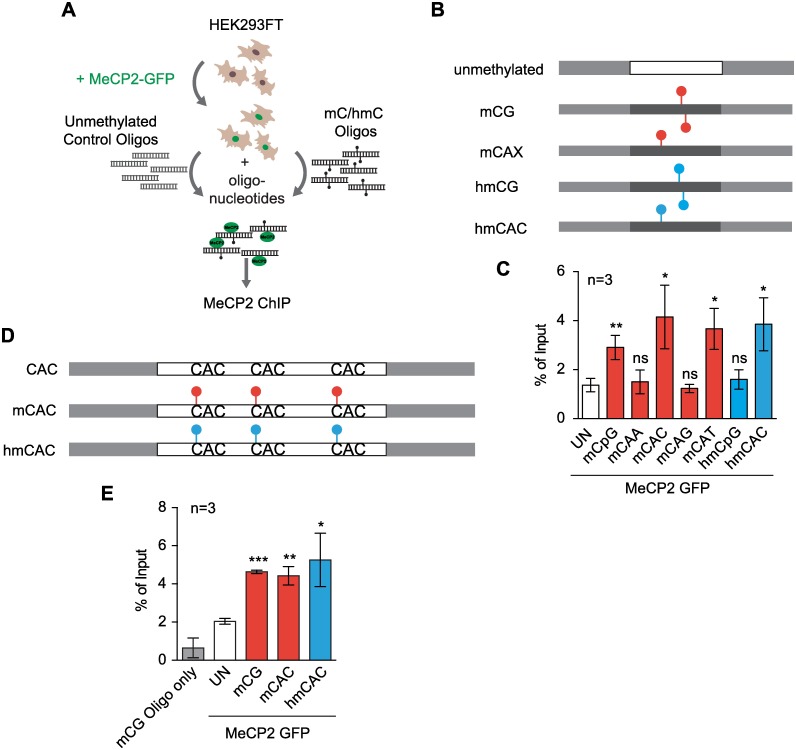
Full-length MeCP2 binds mCAC and hmCAC in vivo.(A) Schematic of in vivo transfection assay in HEK293FT cells. (B) Differentially modified oligonucleotide derived from the mouse Bdnf locus. Light grey: T3 and M13-20 adapters; red circles: mC; blue circles: hmC. See also S1 and S2 Tables. (C) Real Time PCR of in vivo transfection assay in triplicate where WT MeCP2-GFP was co-transfected with oligonucleotide as described in (B). (D) Differentially modified oligonucleotide at three CAC sites. See also S1 and S2 Tables. Light grey: T3 and M13-20 adapters; red circles: mC; blue circles: hmC. (E) Real Time PCR of in vivo transfection assay in triplicates where WT MeCP2-GFP was co-transfected with oligonucleotides as described in (D). Real Time PCR results are presented as % of Input (red bars: mC; blue bars: hmC, white bars: unmethylated; grey bar: mCG oligonucleotide transfected without prior transfection of MeCP2-GFP as a background control). Error bars represent ± SD. Significance was calculated in relation to unmethylated oligonucleotide transfections (white bars). Students unpaired t-test: ns p>0.05; * p<0.05; ** p<0.01; *** p<0.001.